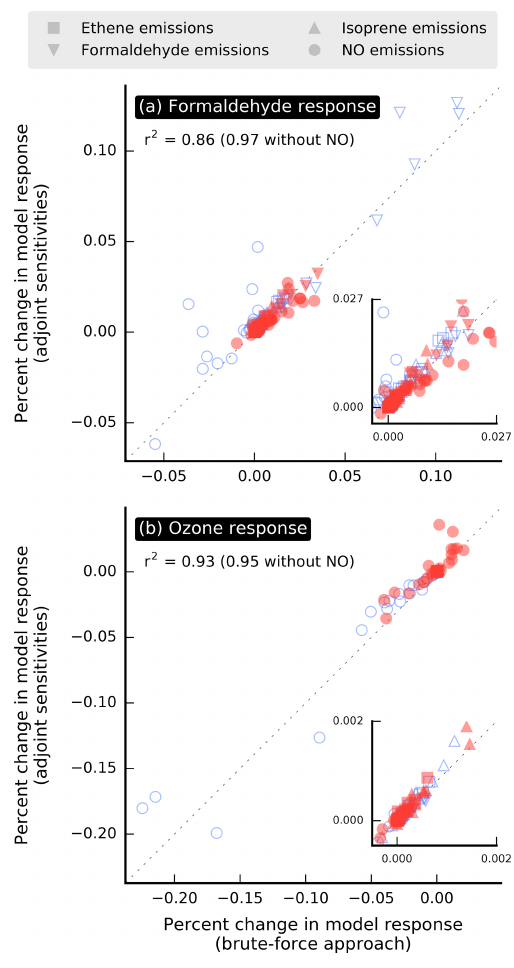
Figure 2. Relative change in model response calculated from first-order adjoint sensitivities versus using a brute-force ap- proach. The model responses used for the evaluation are domain- wide population-weighted mixing ratios of (a) formaldehyde and (b) ozone. Simulation periods used for this evaluation are episodes of 1d in July (red filled symbols) and December (blue unfilled sym- bols). Each point corresponds to the effect of an additive 24h per- turbation in emissions applied to a single grid cell. Insets zoom in on a section of the corresponding plots.